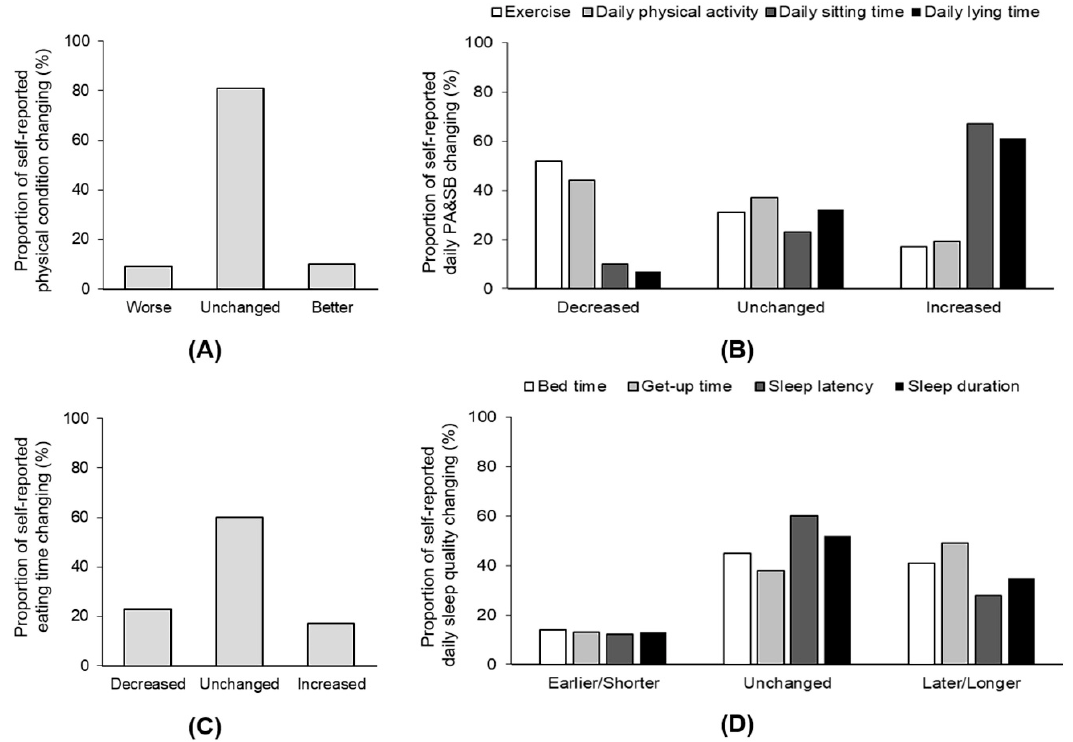
Figure 4. Proportion of self-perceived changes in physical condition and behaviors during the home-isolation period. ( A ) Change in physical condition. ( B ) Change in PA and sedentary behaviors. ( C ) Change in eating time. ( D ) Change in sleep quality.